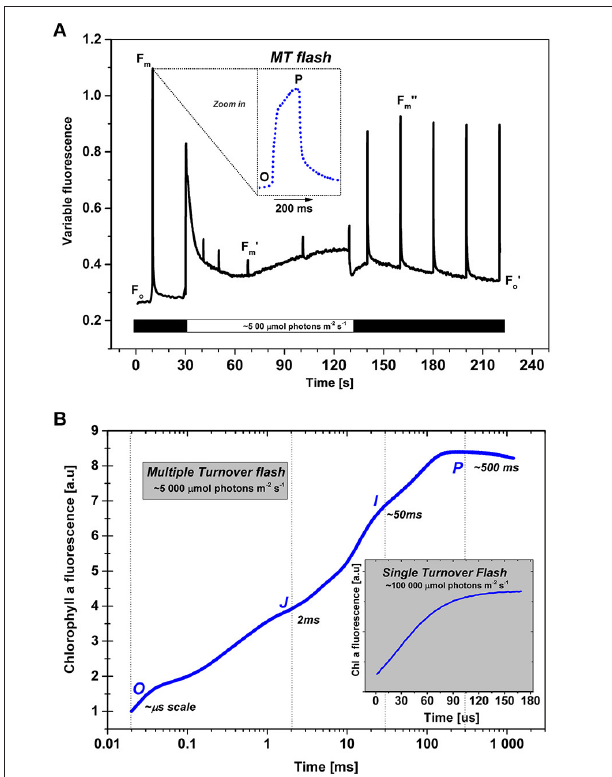
FIGURE 3 | Chlorophyll a fluorescence measurements in photosynthetic organisms. (A) (top): A protocol used for the detection of PSII photochemistry upon exposure with ∼ 500 µ mol photons m − 2 s − 1 light (Krause and Weis, 1991). The minimal level of Chl a fluorescence of open PSII reaction centers plus that from PSI is F o ; it is measured in a dark adapted sample at very low (“measuring”) light ( ∼ 5 µ mol photons m − 2 s − 1 ). The maximal fluorescence in dark-adapted sample is F m , but its changed value during actinic light is referred to as F m ′ , and after the actinic light period light, it is labeled as F m ′′ . In the experiment shown, it was measured with high intensity multiple turnover (MT) flashes ( ∼ 1500 µ mol photons m − 2 s − 1 , flash duration 200 ms), given for a short period ( ∼ 200ms). (Note: MT flash induces multiple events of charge separation in PSII.) The fluorescence increase during the MT flash has a characteristic polyphasic rise to a plateau or a peak (see inserts in both panels A and B). The F m and F m ′ (as well as F m ′′ ) values are used for the calculation of PSII photochemistry as well as for non-photochemical quenching (NPQ) of the excited state of Chl a , the latter equals (Fm-Fm ′ )/Fm. Black bars (near the abscissa) represent periods without actinic irradiation (i.e., darkness), whereas during the open (clear) bar, actinic light is on. The sample used in the experiment shown here was Rhodomnas salina cells (from Kaˇna et al., 2012b). (B) Chl a fluorescence transient measured at high intensity ( ∼ 5000 µ mol photons m − 2 s − 1 ) MT flash (from Kaˇna et al., 2008). The inset shows Chl a fluorescence transient in a short, 100 µ s long, single turnover (ST) flash, at very high irradiation ( ∼ 100 000 µ mol photons m − 2 s − 1 ). Using the MT flash at high light intensity, we observe